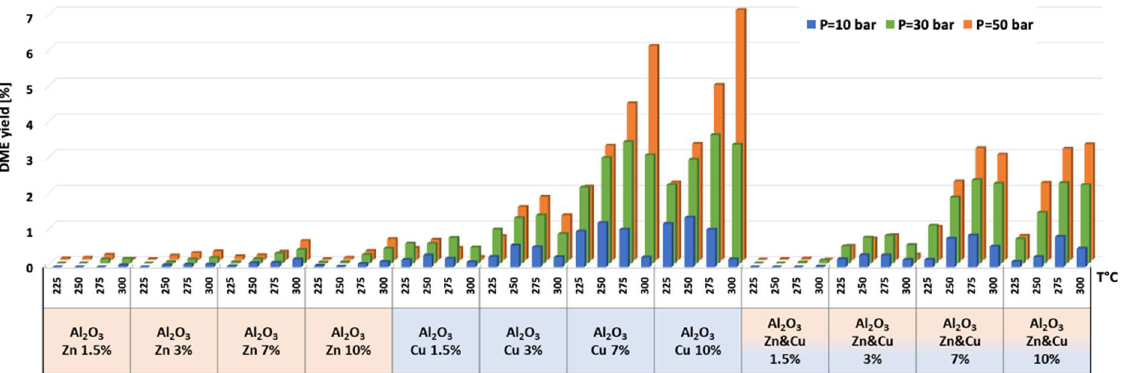
Figure 7. Methanol yield for all catalysts at pressures of 10, 30, and 50 bar and temperatures of 225, 250, 275, and 300 °C.